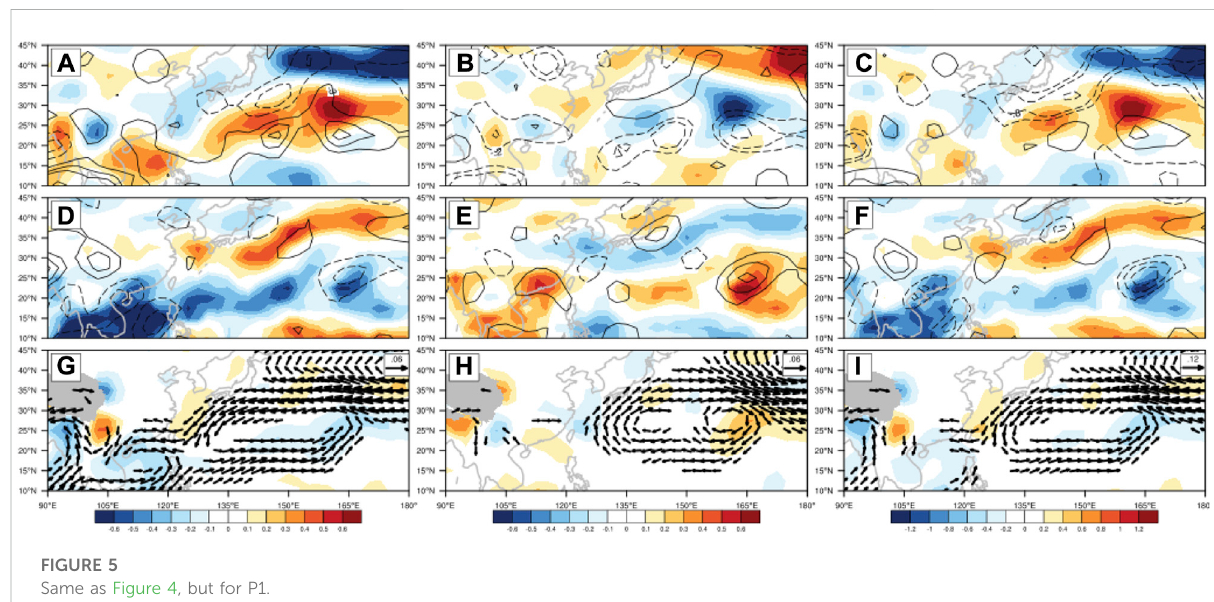
FIGURE 5 Same as Figure 4, but for